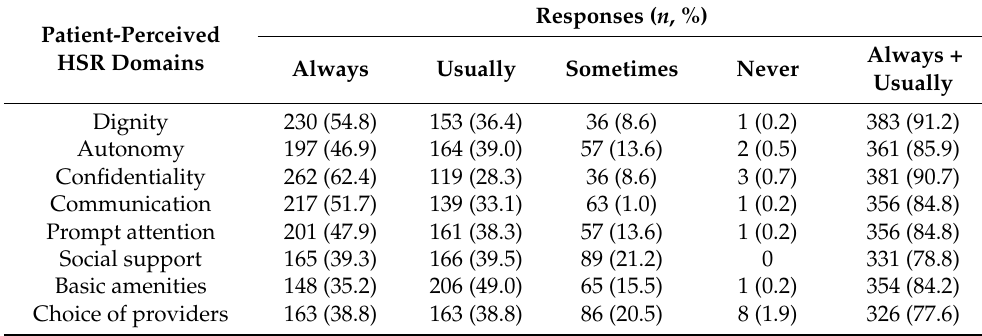
Table 2. Patient-perceived responsiveness of epilepsy care in rural China.